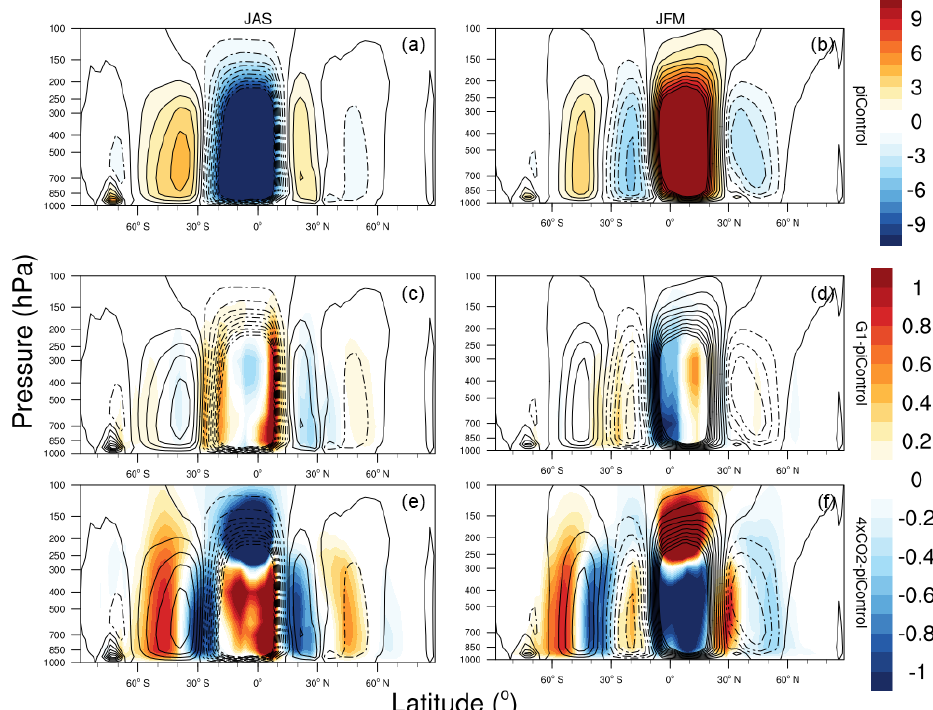
Figure 6. Model ensemble mean meridional stream function in piControl (a, b) , anomalies relative to piControl for G1 (c, d) and anomalies relative to piControl for abrupt4xCO2 experiments (e, f) . Panels (a, c, e) indicate JAS months and panels (b, d, f) indicate JFM months. Color bar indicates the value of averaged meridional mass stream function (10 10 kgs − 1 ). Warm colors (positive values) indicate a clockwise rotation and cold colors (negative values) indicate an anticlockwise rotation. Contours indicate the value of averaged meridional mass stream function (10 10 kgs − 1 ) in